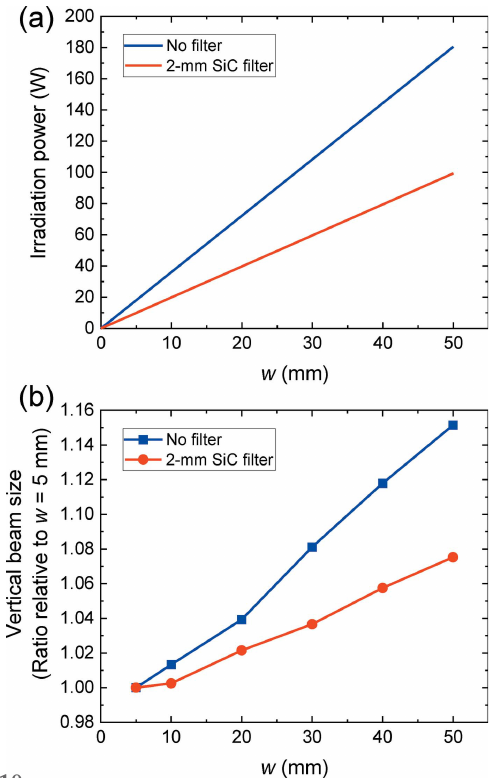
Figure 10 ( a ) Calculated power incident on M1b plotted as a function of the TC slit width ( w ). The blue (red) line indicates the incident power without a filter (with a 2 mm SiC filter). ( b ) Vertical beam size at EH3 as a function of w . The size is normalized by the beam size at w = 5 mm. The blue (red) symbols represent the beam size without a filter (with a 2 mm SiC